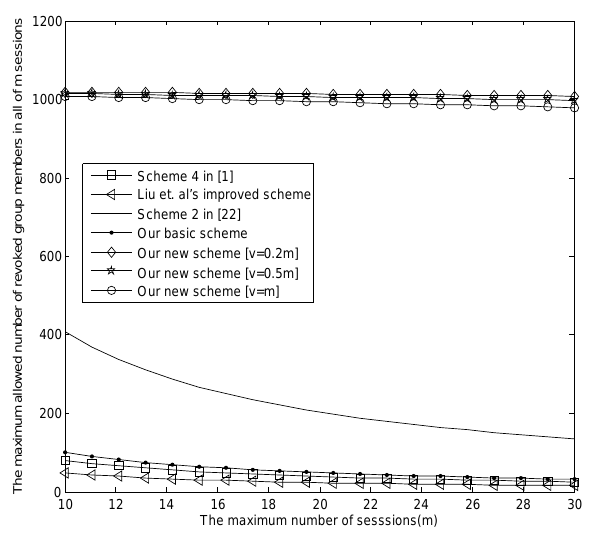
Figure 4. The trade-off between m and | R m | max as the size of the broadcast message is 64